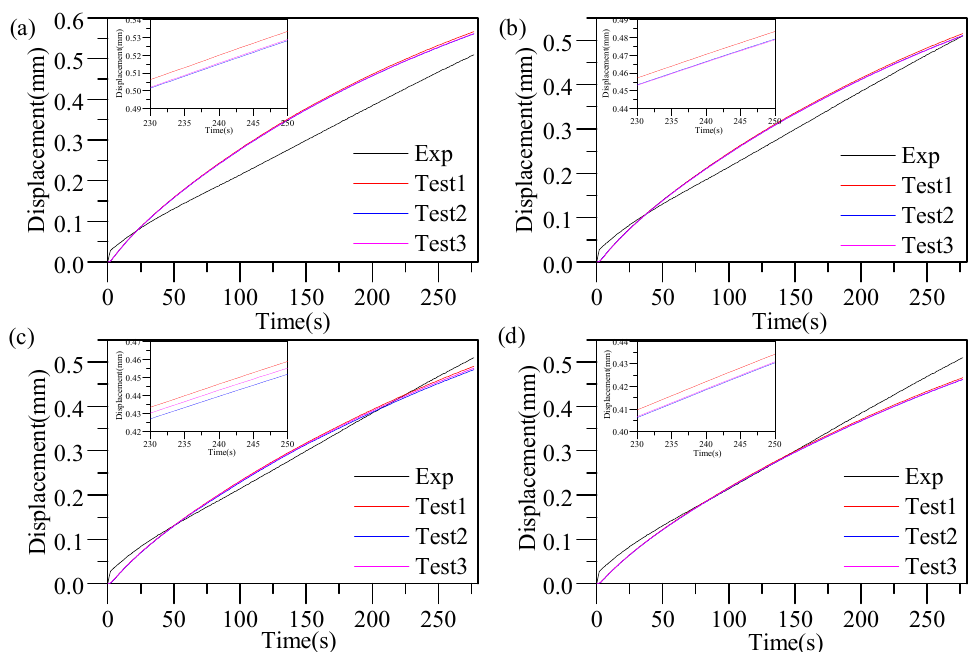
Figure 11. Compression displacement contrast between the simulation and experiment: ( a ) 546 °C; ( b ) 544 °C; ( c ) 543 °C; ( d ) 542 °C.